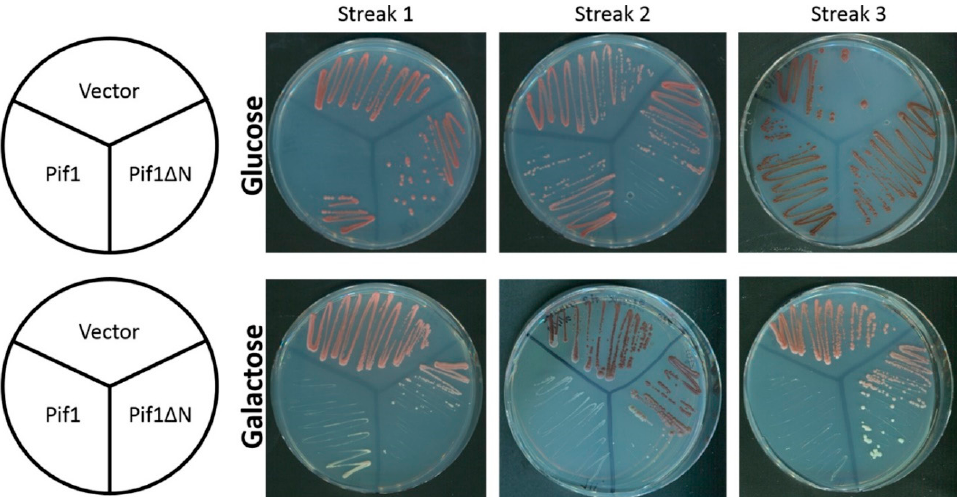
Figure 3. Chronic overexpression of Pif1 leads to cellular senescence. Wild-type yeast cells